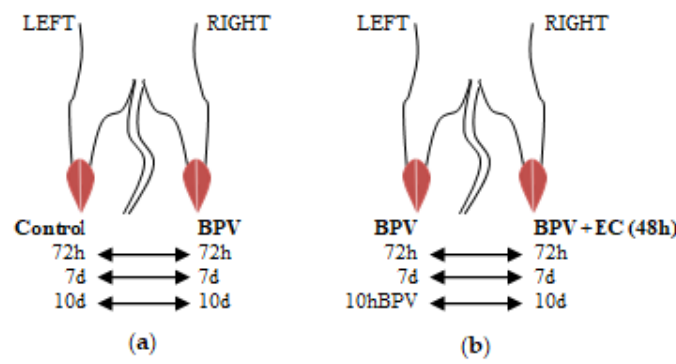
Figure 1. Electromyography: experimental design. This figure displays how the experimental and control groups for electromyography recordings were created. For each animal, the control limb was compared to the experimental limb. ( a ) After BPV was injected into the right limb and the same volume of saline was injected into the left limb (control), electromyography assessments of both limbs were performed at 72 h and 7 and 10 days. ( b ) Electromyography of both limbs was performed: left limb BPV, right limb BPV + PNE at 72 h and 7 and 10 days. Forty-eight hours after the application of BPV, PNE was applied. The PNE protocol was only administered in the right limb of each animal. Thereafter, electromyography of both limbs was performed (left limb BPV; right limb BPV + PNE) at 72 h and 7 and 10 days. BPV, bupivacaine. EC, electrical currents.